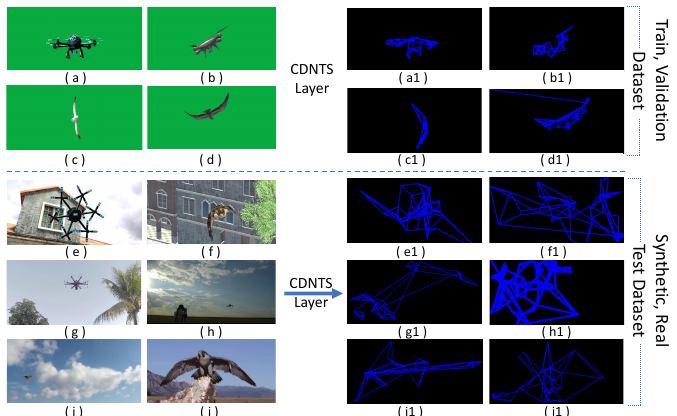
Figure 6. Sample output images of the CDNTS algorithm. ( a – d ) synthetic RW-UAV and bird images samples for the training process; ( a1 – d1 ) transformed shape by CDNTS layer of a–d labeled images; ( e , f ) synthetic RW-UAV and bird images samples for the test process; ( e1 , f1 ) transformed shape by CDNTS layer of e,f labeled images; ( g – j ) real RW-UAV and bird images samples for the test process; ( g1 – j1 ) transformed shape by CDNTS layer of g – j labeled